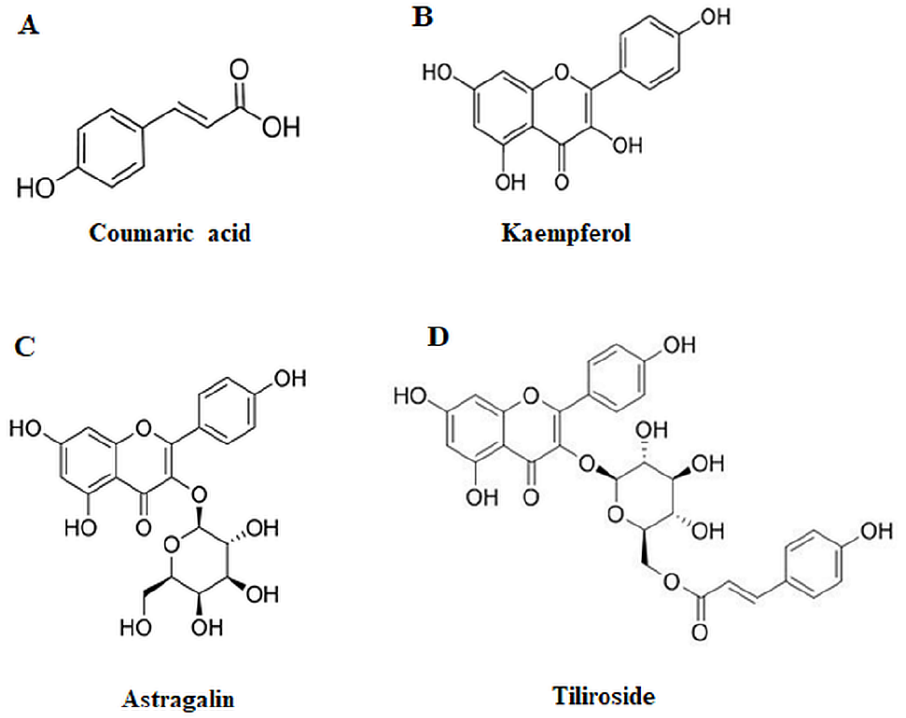
Figure 1. Structures of selected compounds— p -coumaric acid ( A ), kaempferol ( B ), astragalin ( C ) and tiliroside ( D ).